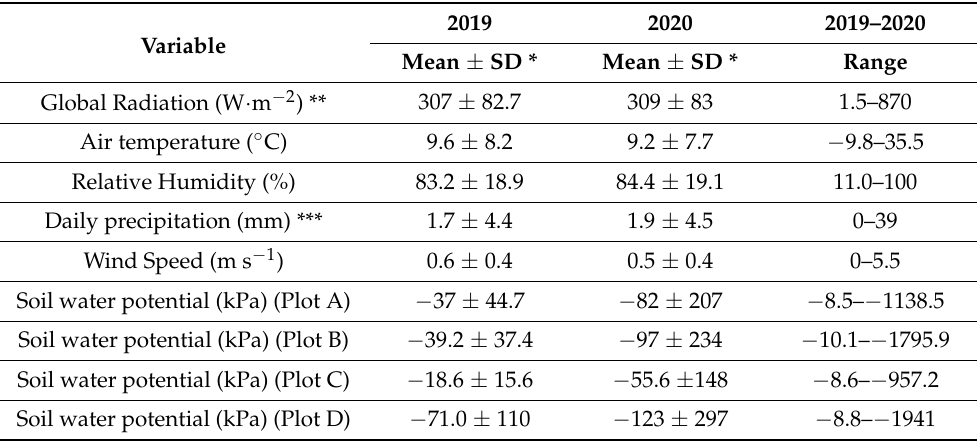
Table 2. Mean values (mean ± standard deviation) of some of the climate variables were measured at the study site. * Standard deviation. ** Global radiation in the column represents the mean daytime radiation. *** Daily precipitation data were obtained from annual precipitation by dividing them by 365.